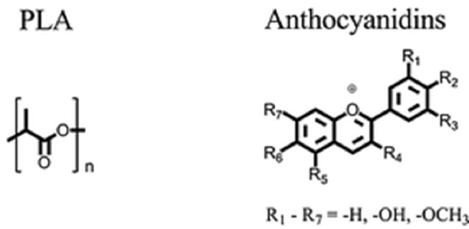
Figure 11. Molecular structures of PLA and anthocyanidins. Reproduced with the permission of Reference [39]. Copyright The Royal Society of Chemistry.